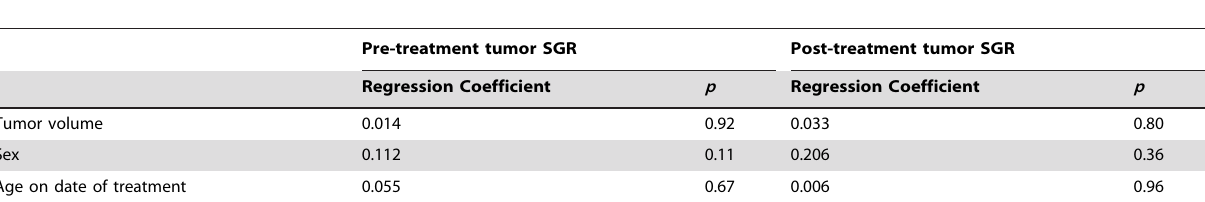
Table 2. Correlation between tumor volume, sex, and age, with pre-treatment and post-treatment SGRs.